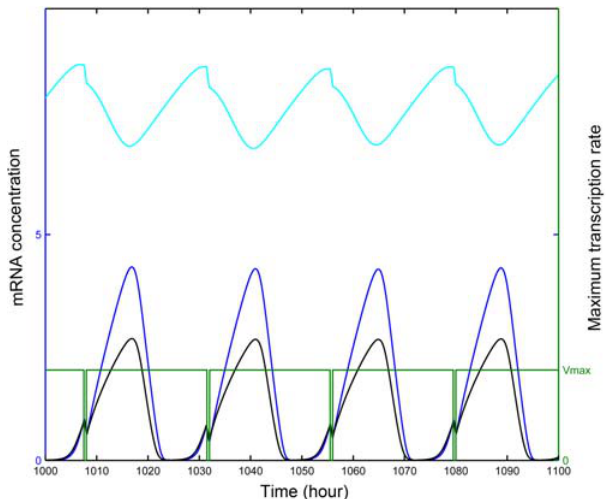
Figure 1. Square wave representing the transcriptional inhibi- tion during cell cycle M phase. The square wave (green) oscillates between a maximum value, which represents the maximum transcrip- tion rate of the mRNAs, and zero, which represents the inhibition of transcription during M phase. The period of the square wave represents cell cycle period. The transcription of the three mRNA species (black, blue, and cyan) are simultaneously inhibited during the M phase.